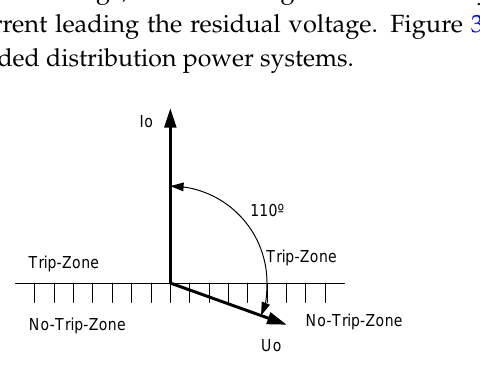
Figure 3. Tripping zone for solidly grounded power distribution networks. (Uo) Residual voltage; (Io) Residual current; (110°) Characteristic tripping angle.